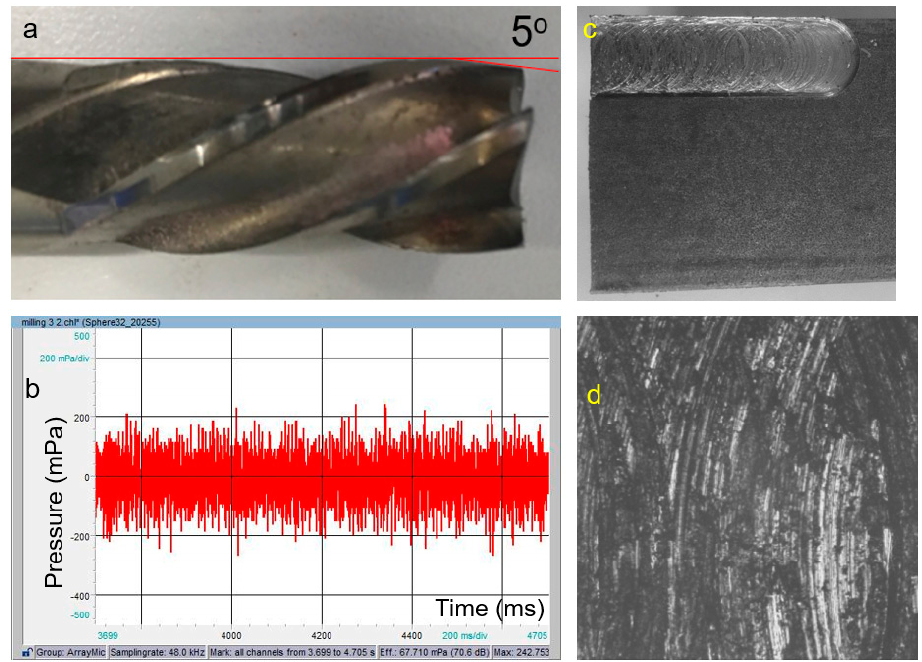
Figure 9. Acoustic and surface measurement for Tool 3 during milling: ( a ) image of tool with wear condition; ( b ) noise emission during load (Feed = 3 in/min; depth of cut = 0.05 in and RPM = 750); ( c ) milled piece; and ( d ) image on surface roughness.